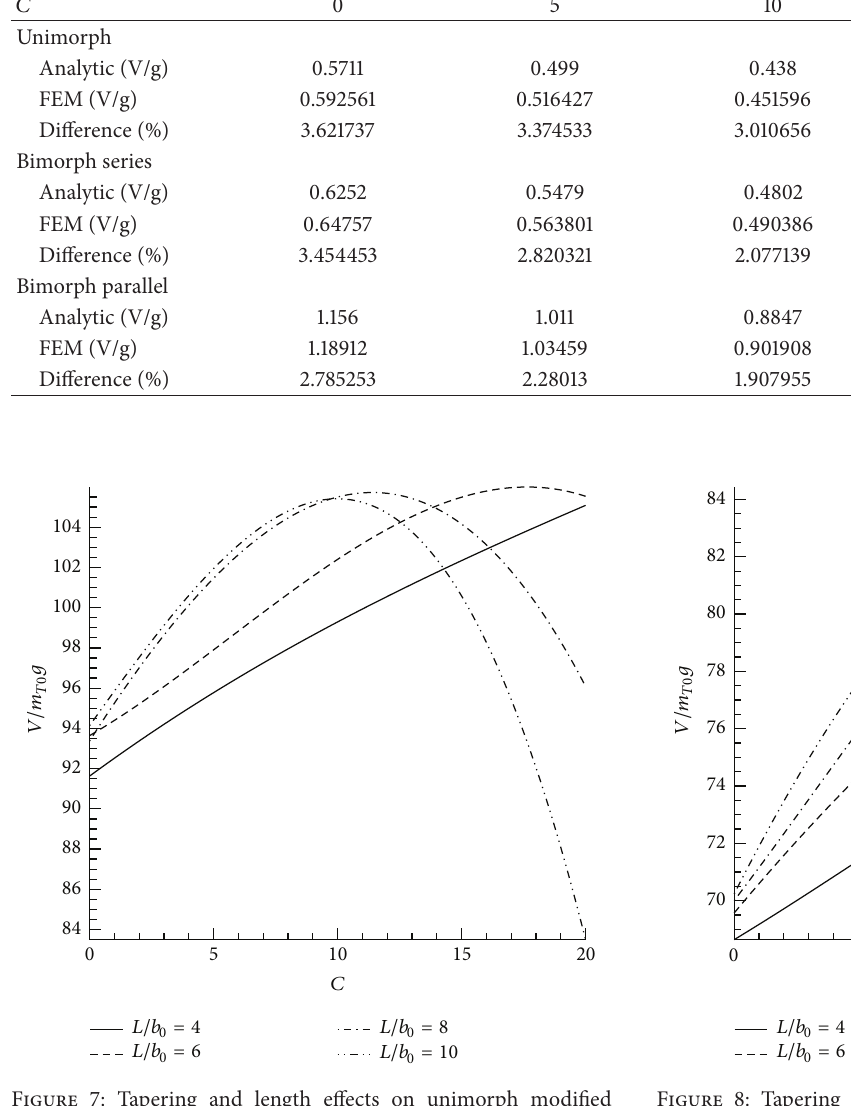
Figure 7: Tapering and length effects on unimorph modified thickness.